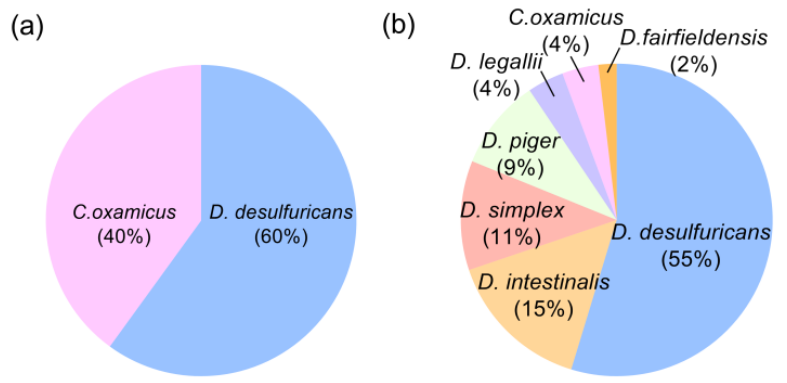
Figure 1. Percentage of different Desulfovibrio strains from gut of ( a ) patients with liver cirrhosis (Total = 35) and ( b ) healthy volunteers (Total = 53).